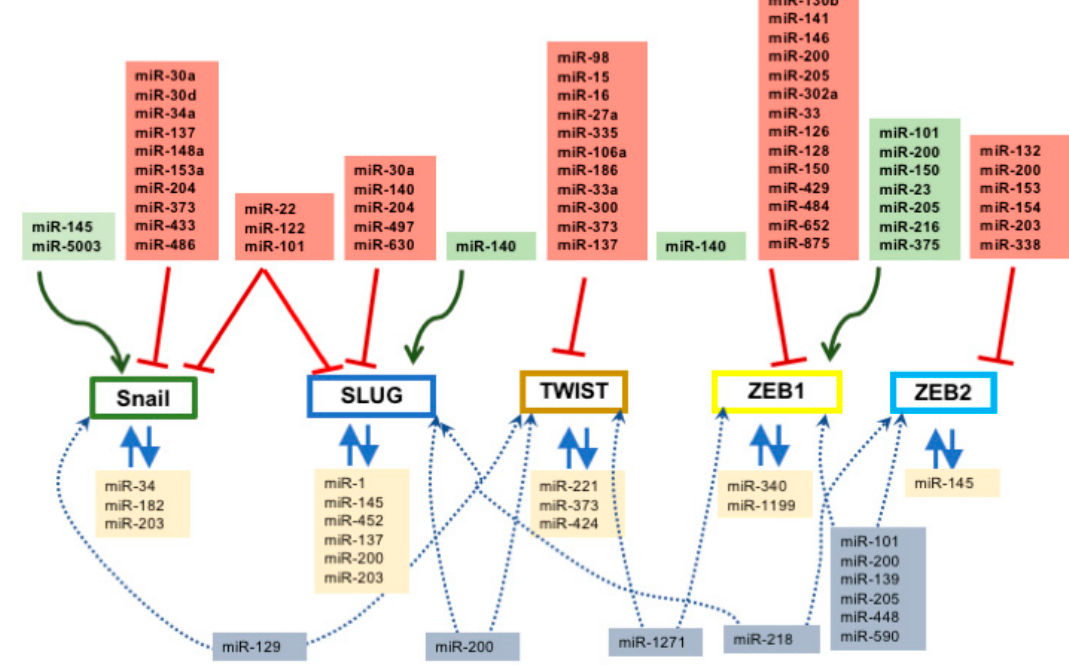
Figure 1. Schematic representation of the microRNAs regulating the epithelial-to-mesenchymal transition (EMT)-associated transcription factors Snail , Slug , Twist , Zeb1 , and Seb2 . Red lines demarcate inhibitory pathways, green lines demarcate activation pathways. Dotted lines delineate those microRNAs modulating the expression of different transcription factors, whereas blue arrows display regulatory loops.